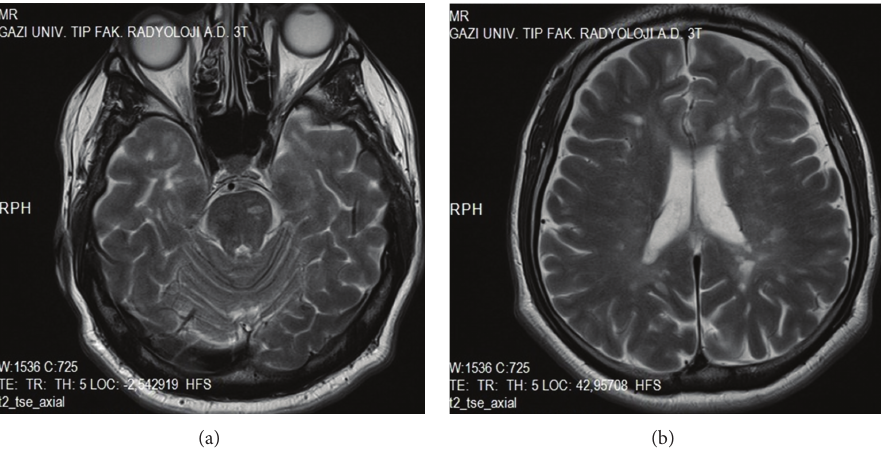
Figure 1: (a) Demyelinating periventricular lesions, (b) demyelinating lesions in the pons, T2 weighted axial section, and brain MRI.